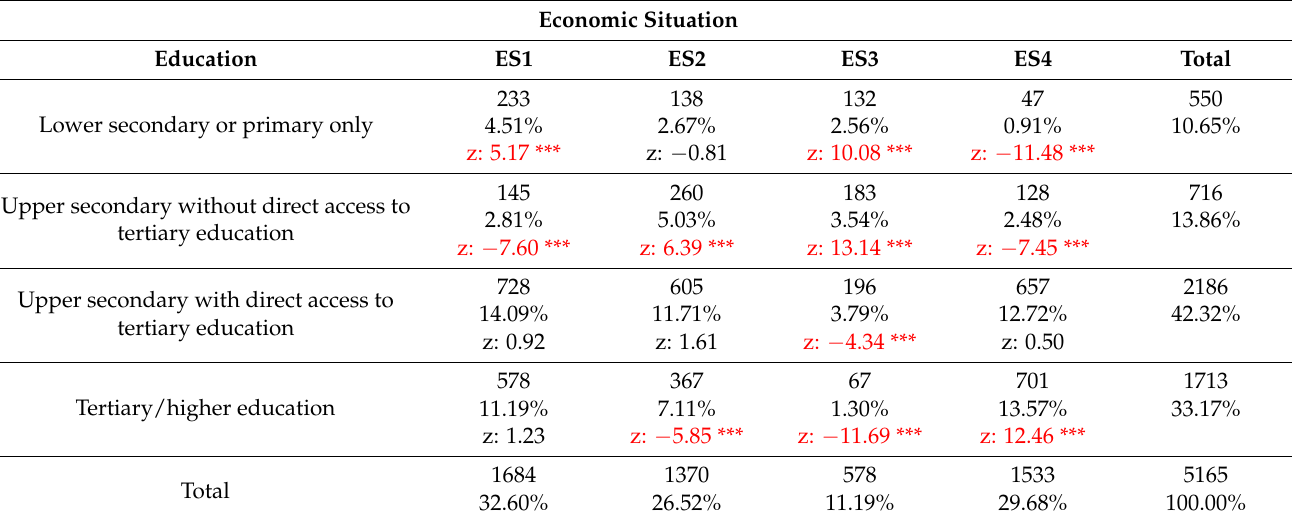
Table 3. Economic situation’s dependence on education.